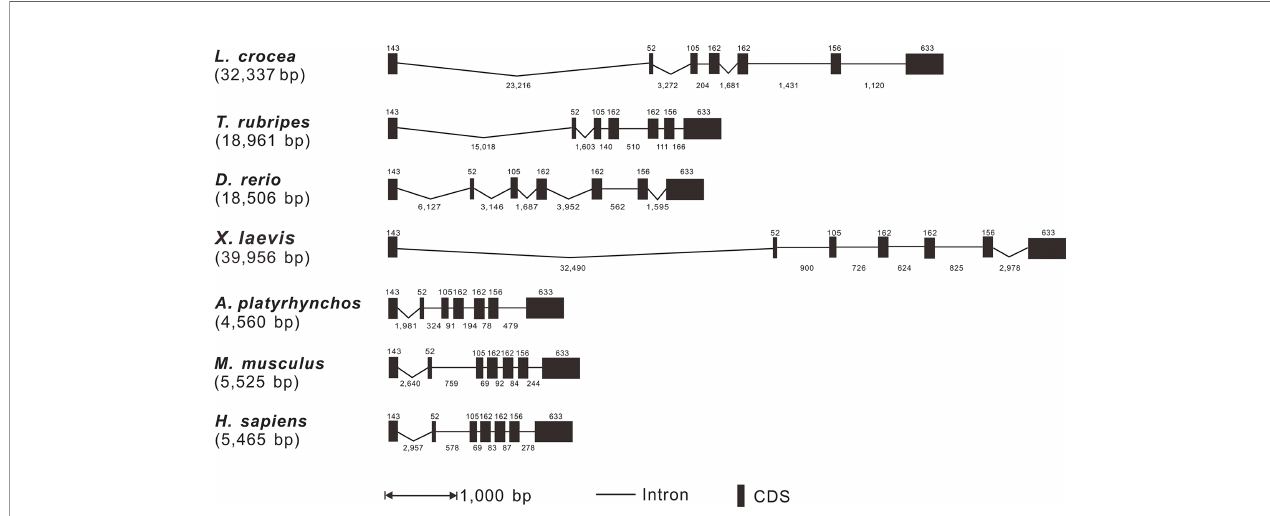
FIGURE 2 | Genomic organization comparison of Lc - TRAF4 with other vertebrates. Comparison of exons and introns of TRAF4 gene in L. crocea , T. rubripes , X. laevis , A. platyrhynchos , D. rerio , M. musculus and H. sapiens . Exons and introns are represented by black boxes and lines, respectively, with the length of the exon shown above the black box and the length of the intron shown below the line. The length of the black box and the length of the line is proportional to the length of the sequence. Gene sequences information and their GenBank association numbers are shown as follows: L. crocea , NC_040017.1 (20102011-20136861); T. rubripes , NC_042295.1 (11474831-11495738); D. rerio , NC_007132.7 (39005909-39024739); X. laevis , NC_054374.1 (4177010-4219063); A. platyrhynchos , NC_051791.1 (5126618-5131704); M. musculus , NC_000077.7 (78049249-78056405); H. sapiens , NC_000017.11